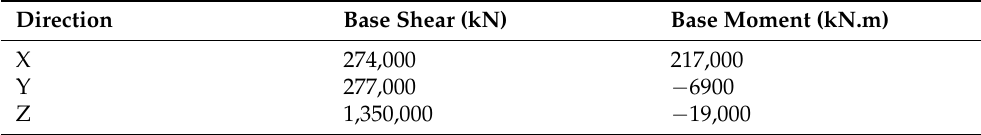
Figure 18. Deformed shape of the first floor influenced by the dead and live loads.